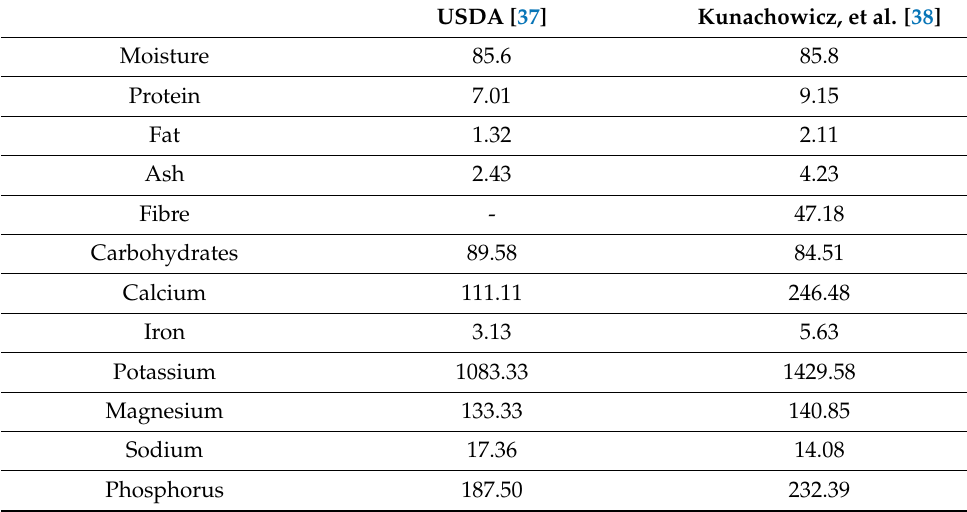
Table 3. Composition of raspberry fruit based on data from FoodData Central—US Department of Agriculture (USDA) [37] and Kunachowicz, et al. [38] (basic composition expressed as g 100 g − 1 DW, minerals in mg 100 g − 1